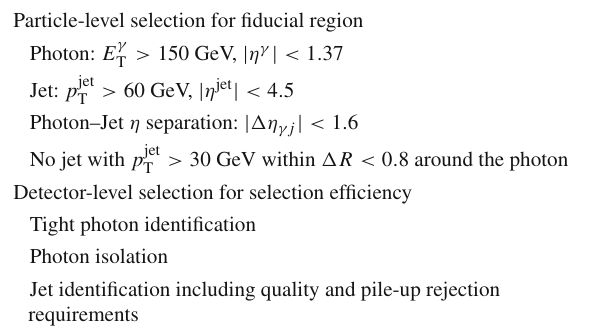
Table 2 Requirements on the photon and jet at particle level to define the fiducial region and on the detector-level quantities for the selection efficiency Particle-level selection for fiducial